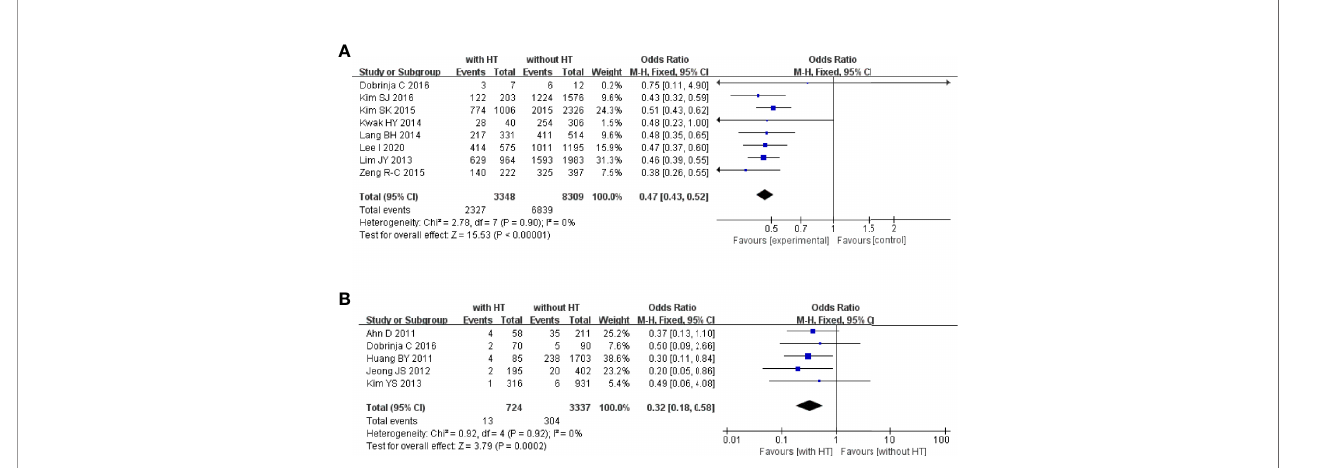
FIGURE 5 | (A) Forest plot of HT and BRAFV600E mutation; (B) forest plot of HT and recurrence.